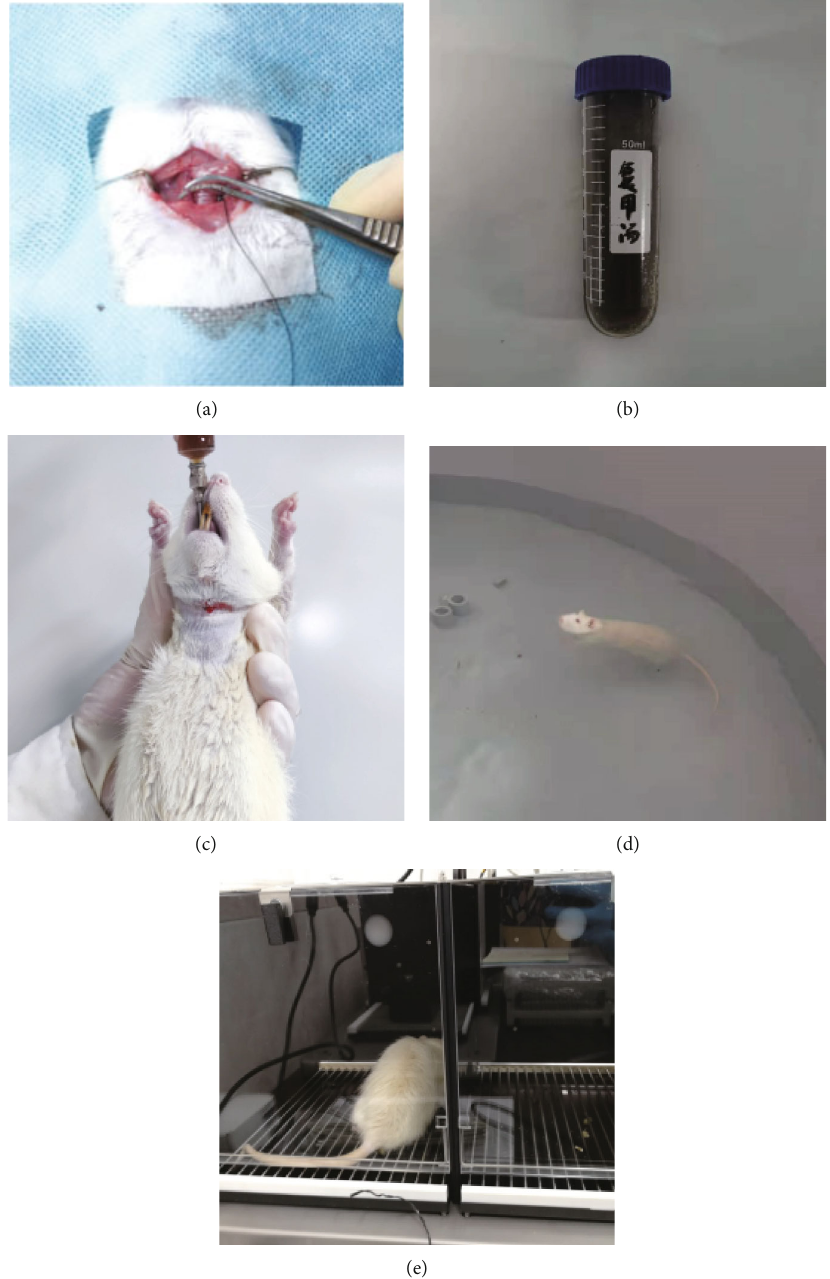
Figure 1: VCI rat modeling and behavioral detection. (a) VCI model preparation using the modi fi ed Pulsinelli ’ s four-vessel occlusion method. (b) – (c) Intragastric administration. (d) Morris water maze experiment. (e) Shuttle box